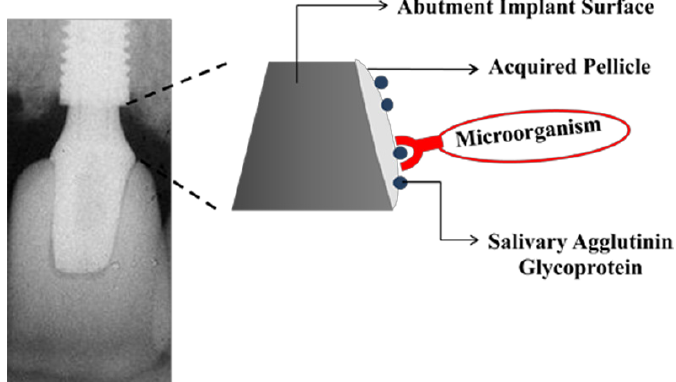
Figure 1. Image showing salivary acquired pellicle formation upon an implant surface as the first step in biofilm